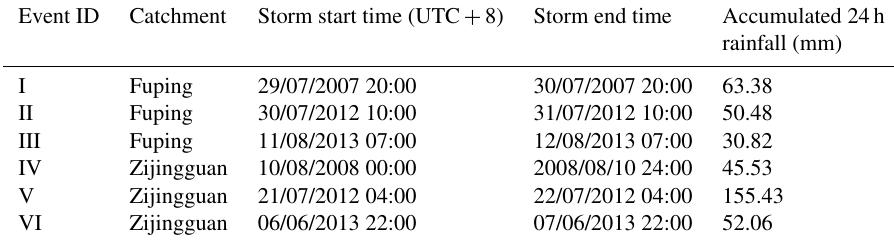
Table 2. Durations and rainfall accumulations of the six selected 24h storm events.